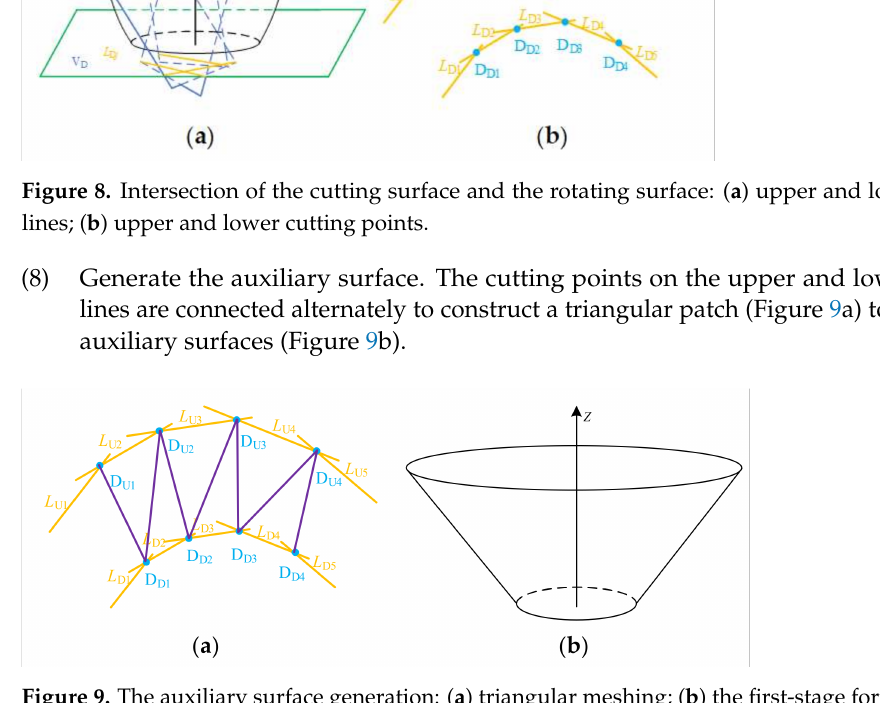
Figure 9. The auxiliary surface generation: ( a ) triangular meshing; ( b ) the first-stage forming